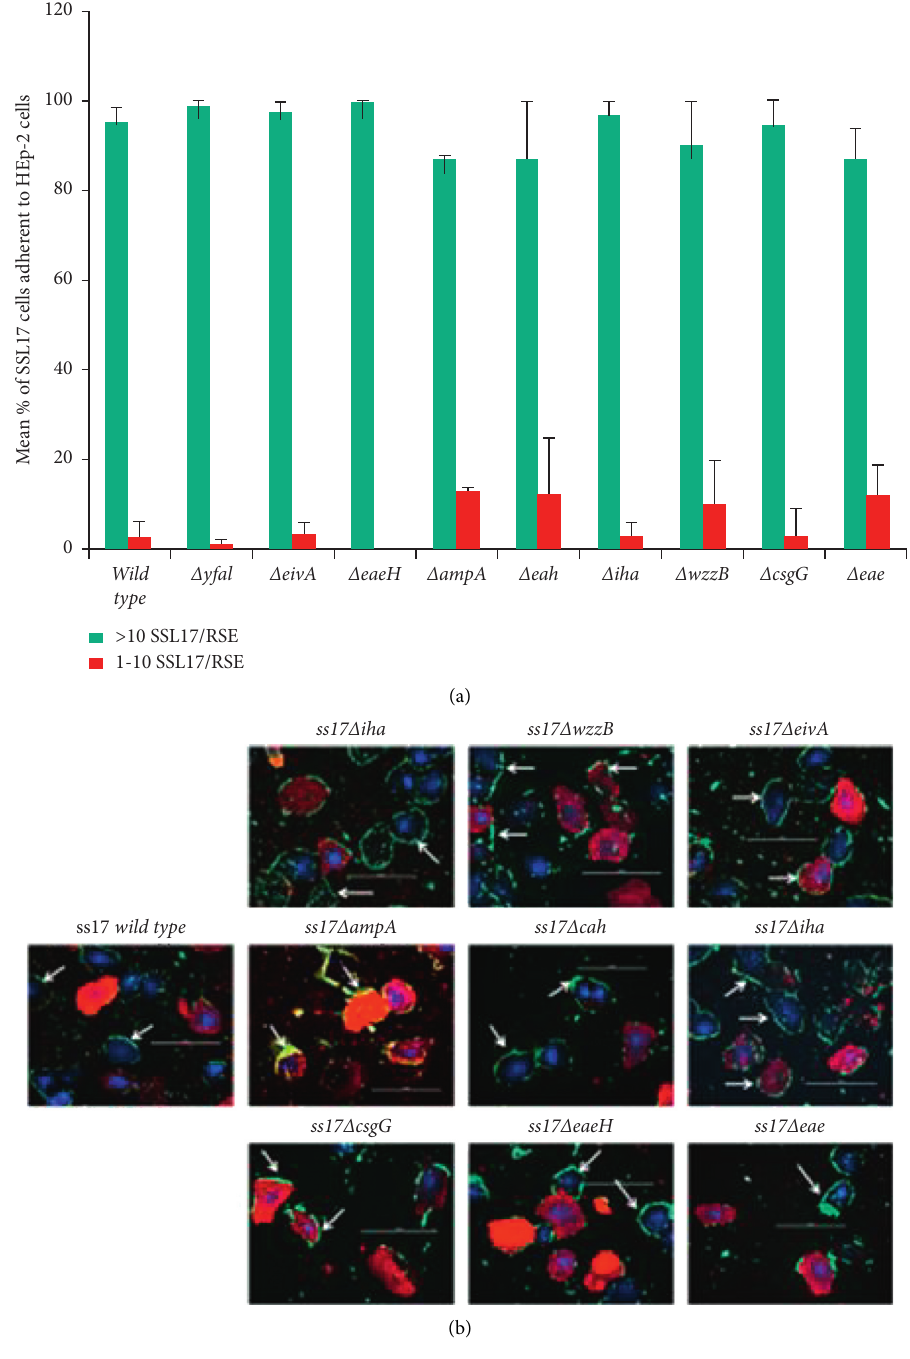
Figure 6: SS17 adherence mutant phenotypes on RSE cells. The parental strain and the adherence-associated gene mutants of SS17 were tested for adherence quantitatively (a) and qualitatively (b) on RSE cells. As the results show, none of the mutations significantly altered SS17’s ability to bind RSE cells with its distinct aggregative, strong adherence. (a) Each bar is representative of four technical replicates per slide where 20 cells/spot were counted over two trials. The bar is the mean percentage of adherent bacteria ( > 10 or 1–10) per RSE cell over the two trials. (b) Immunofluorescence of SS17 adherence pattern on RSE cells. Bacteria are labeled with green, RSE cell cytokeratins with red, and RSE cell nuclei with DAPI (blue) fluorescent staining. The scale bar for each panel is set to 100 μ m and the white arrows show the O157 on RSE